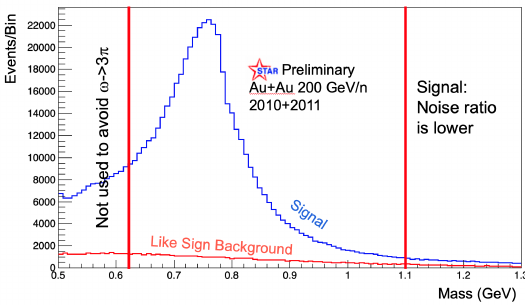
Figure 1: Mass spectrum for unlike-sign and like-sign dipion